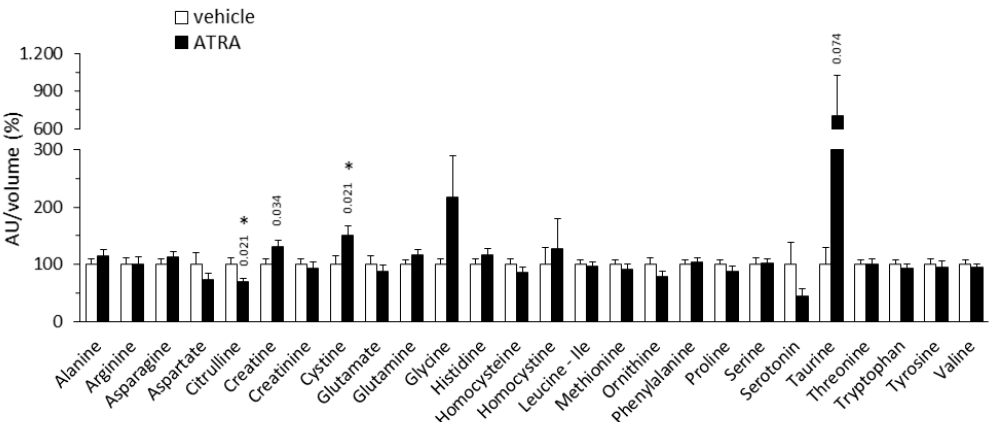
Figure 2. Relative plasma levels of amino acids in NMRI mice treated with all-trans retinoic acid (all-trans retinoic acid (ATRA; 50 mg/kg body weight, subcutaneous injection) or the vehicle (olive oil) during 4 days. Metabolite peak area (as arbitrary units, AU) was normalized by the volume of plasma used in LC-MS/MS. Data are expressed as percentage with respect to the normalized value in the control group, which was set to 100%, and are the mean ± SEM of 11 animals per group. * Indicates significant difference between the ATRA and the control group after Benjamini–Hochberg correction (observed p values in two-tailed Student’s t test are indicated when p < 0.1).